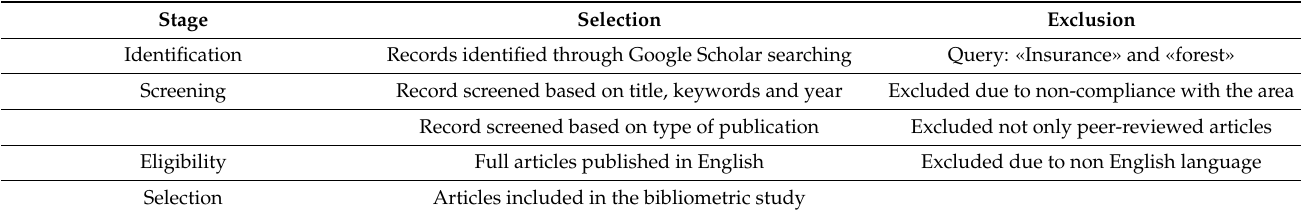
Table 1. Flow chart to identify articles for the bibliometrics